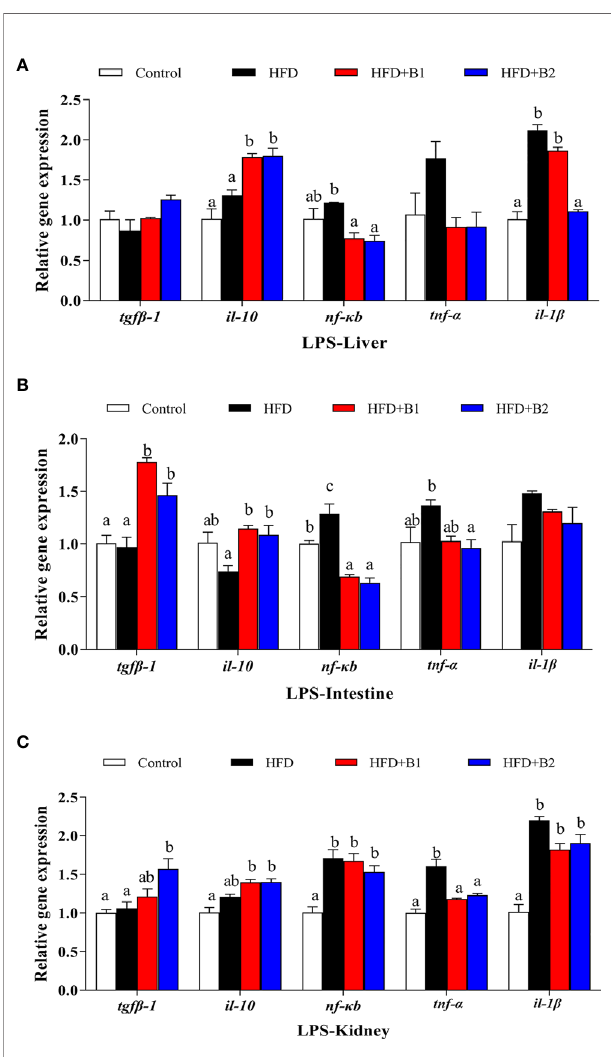
FIGURE 8 | Effects of LPS on in fl ammation gene expression in liver, intestine and kidney of juvenile black seabream ( Acanthopagrus schlegelii ) (% wet weight) fed the experimental diets [Control: 11% crude lipid; HFD: high-fat diet; HFD+B1: HFD +betaine (10g/kg); HFD+B2: HFD + betaine (20 g/kg)] for 8 weeks. (A) The relative mRNA expression of tgf b -1 , il-10 , nf k b , tnf- a and il- 1 b in liver. (B) The relative mRNA expression of tgf b -1 , il-10 , nf k b , tnf- a and il-1 b in intestine. (C) The relative mRNA expression of tgf b -1 , il-10 , nf k b , tnf- a and il-1 b in kidney. Control was used as the reference group, and the mRNA expression levels of target genes were normalized relative to the expression of b -actin . Values are means (n = 3) with standard errors represented by vertical bars. Mean values for the same gene with different letters were signi fi cantly different ( P <